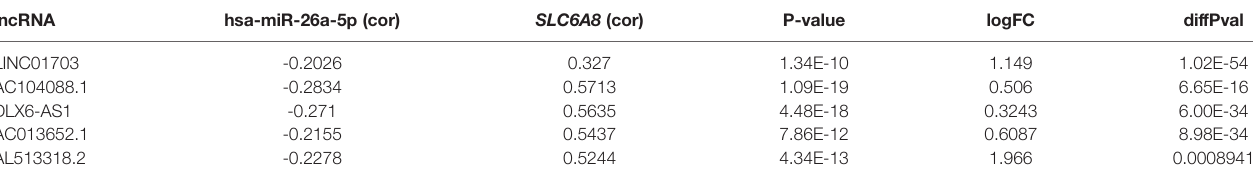
TABLE 3 | Targeted lncRNAs in the ceRNA network associated with hsa-miR-26a-5p and SLC6A8 expression. lncRNA